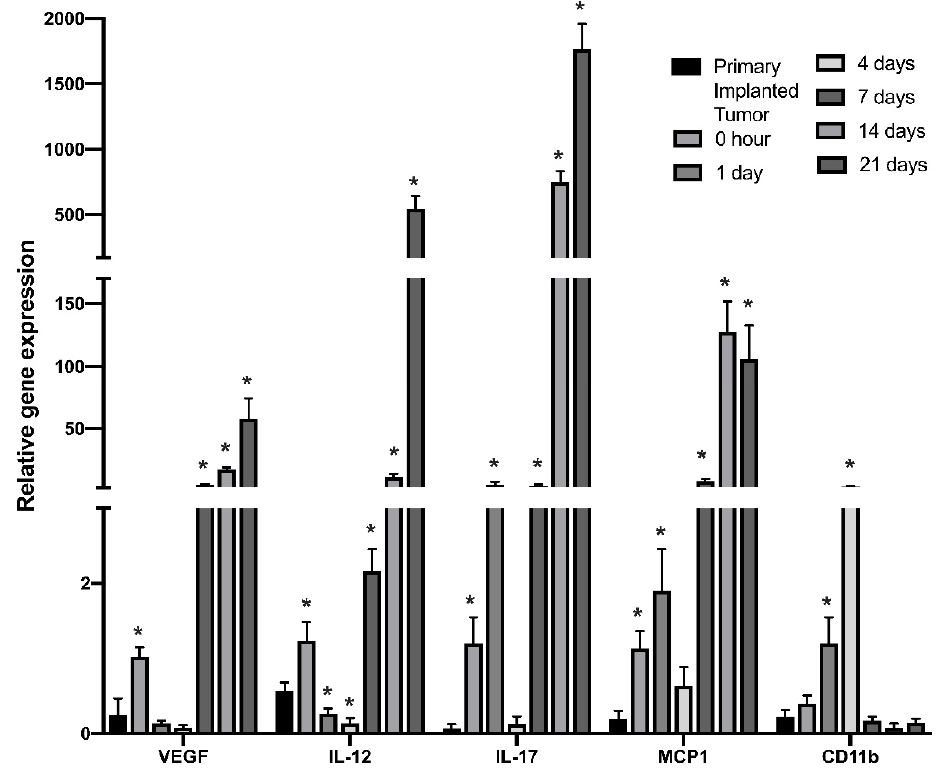
Figure 3. Real-time PCR analysis of cytokine gene expression in cells of myeloid lineage isolated from the tumor-resected area in the GL261/C57Bl/6 mouse glioma implantation model. RT-PCR analysis was performed for myeloid cells purified from tumors before resection and from the tumor resection site at 0, 1, 4, 7, 14, and 21 days after surgical resection. Mean + S.E., and significant differences from primary implanted tumor before resection (* p < 0.005) are shown ( N = 3).